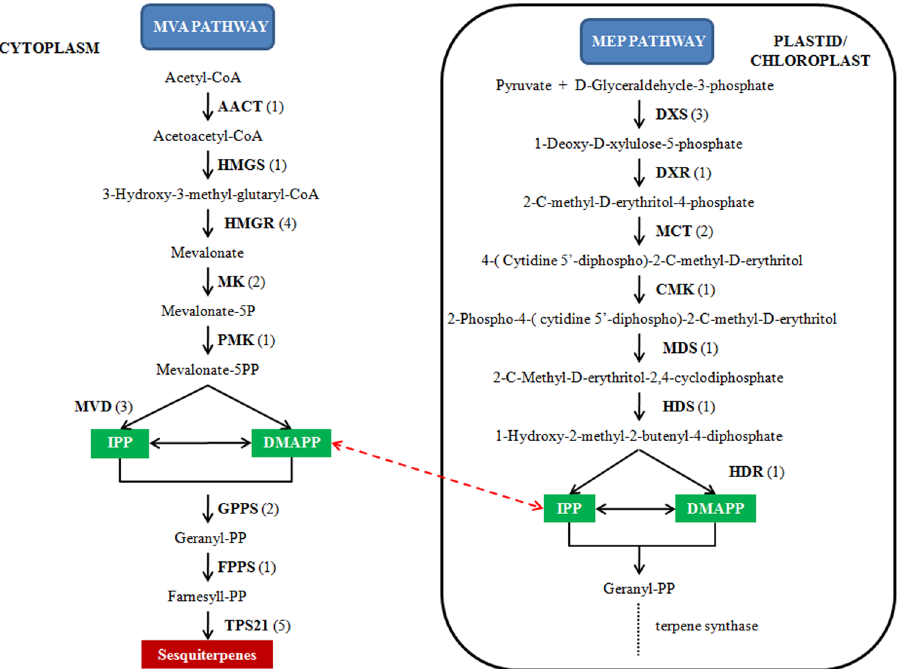
Figure 9. Putative genes involved in the MVA and MEP pathways. The numbers in brackets following each gene name indicate the number of unigenes annotated to that gene. For each gene abbreviation, its full name and other information can be verified from Supplementary Table